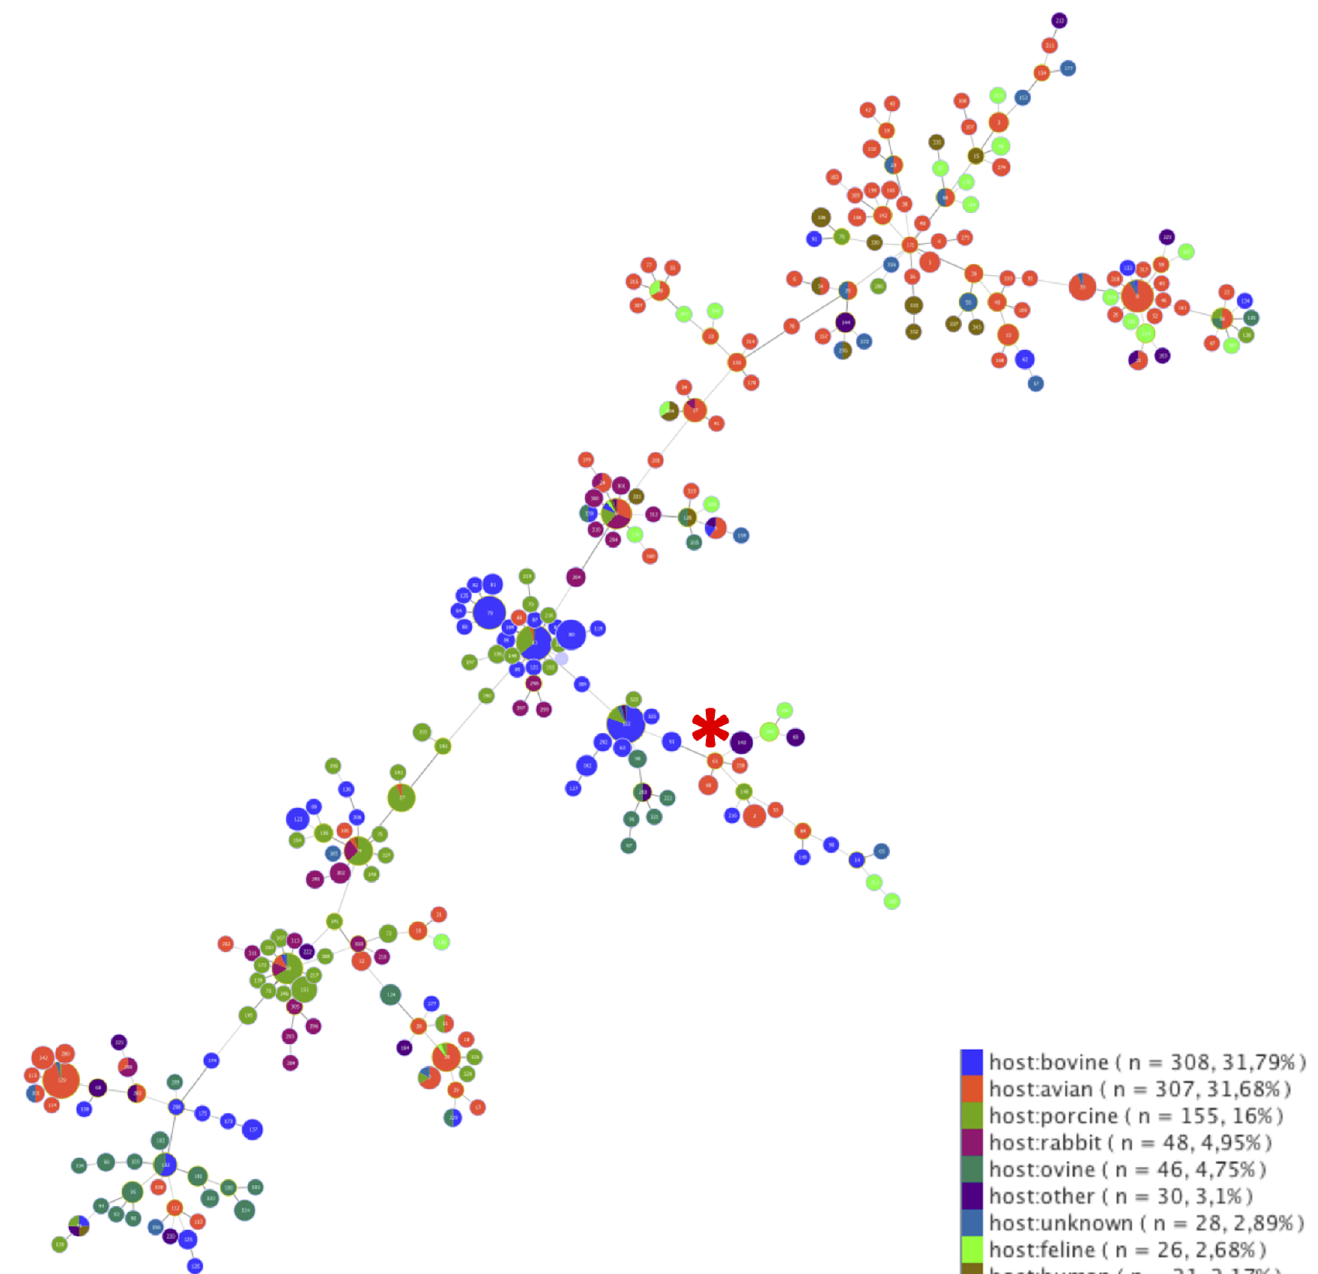
Fig 3. Minimum-spanning tree of Pasteurella multocida sequence types (STs) based on the MLST Scheme (http://www.pubmlst.org/pmultocida/). Each circle represents a ST (reference numbers are inside circles). ST61 is specified by a vertical black arrow. The color code indicates the animal origin of sequenced isolates available in the database, n represents the number of these isolates for each animal